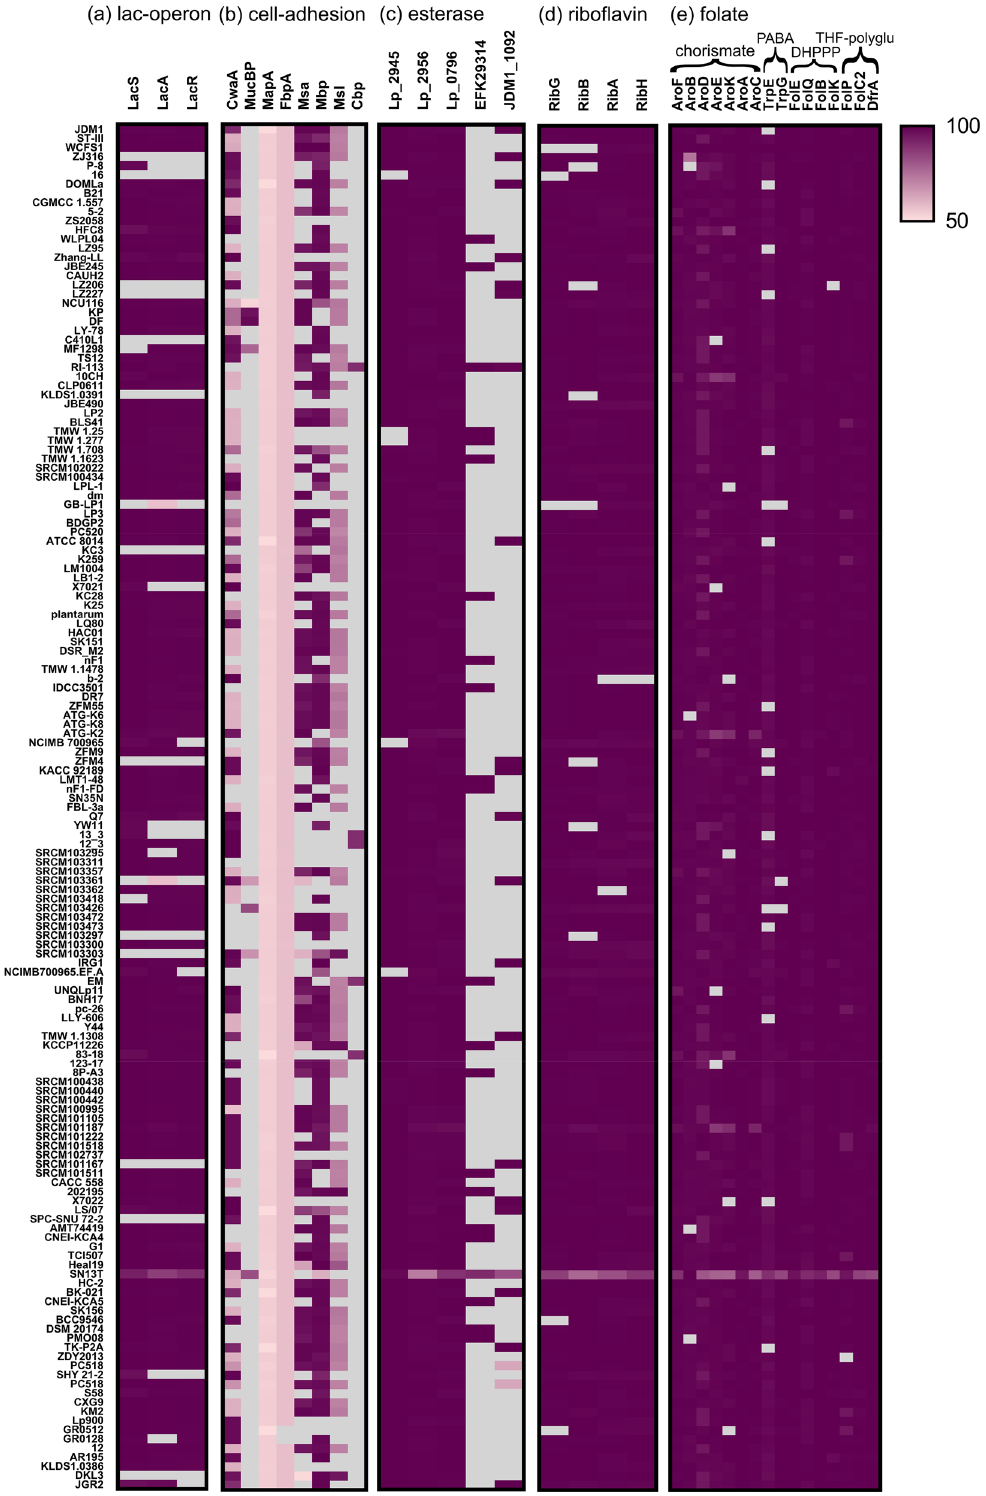
Figure 3. Comparative genomics of L. plantarum strains for the presence of genes encoding proteins related to lactose utilization, adhesion, metabolism of phenolics, and vitamin biosynthesis. BLASTp results depicted as heatmaps with grey color denoting no hit and pink to dark purple gradation denoting presence of genes with 50%-100% identity with the query sequences. ( a ) Lac operon, LacS: lactose and galactose permease, LacA: β-galactosidase, LacR: lactose transport regulator. ( b ) Cell-adhesion related proteins, CwaA (cell wall-anchored adhesion- associated protein), MucBP (mucin-binding protein), MapA (mucus adhesion-promoting protein), FbpA (fibronectin-binding protein A), Msa (mannose-specific adhesin), Mub (mucus-binding protein precursor), Msl (mannose-specific lectin), and Cbp (collagen-binding protein). See Table S3 for the details of the proteins used as the query sequences. ( c ) Esterases characterized from L. plantarum , Lp_2945 (Gallate decarboxylase from WCFS1), Lp_2956 (Tannase from WCFS1, Lp_0796 (Esterase from WCFS1), EFK29314 (Tannase from ATCC14917) and JDM1_1092 (Esterase from JDM1). ( d ) Riboflavin and ( e ) folate biosynthesis proteins, adapted from 36